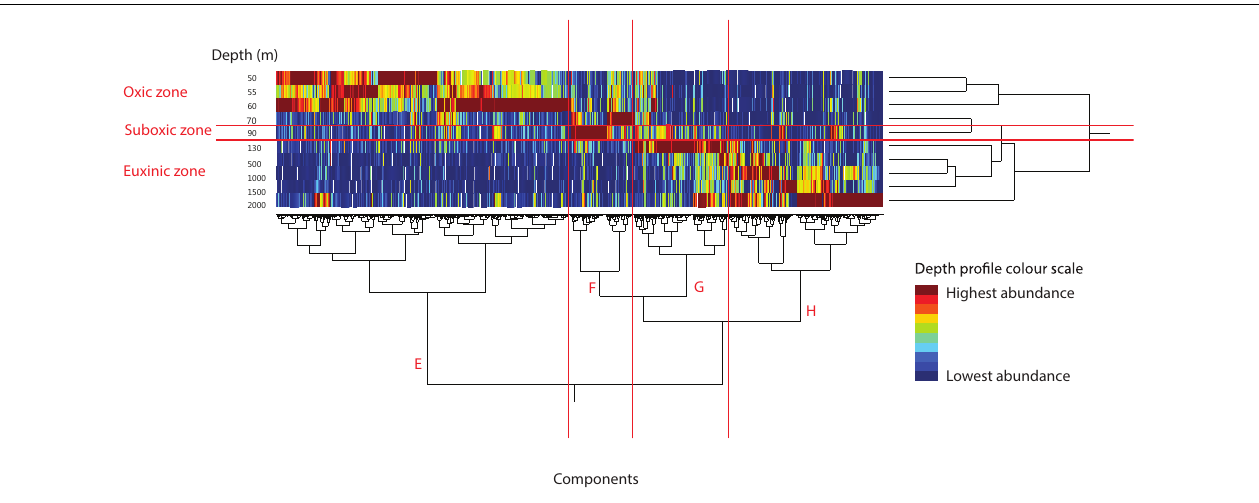
FIGURE 3 | Heat map of the peak area of 12,372 components in Black Sea SPM from March 2017 as extracted by MZmine software. Color scheme represents component’s depth profile, red, highest abundance; and blue, lowest abundance. SPM extracts clustered by similarity in component distribution on the vertical axis and components clustered by similarity of depth profile through water column on the horizontal axis. Red annotations show the water column redox zones, as given in Table 1